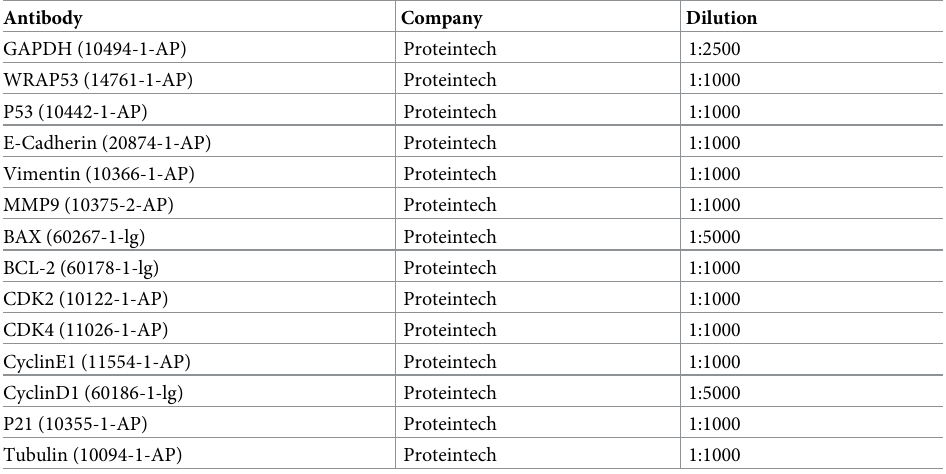
Table 2. Antibodies used in this study.